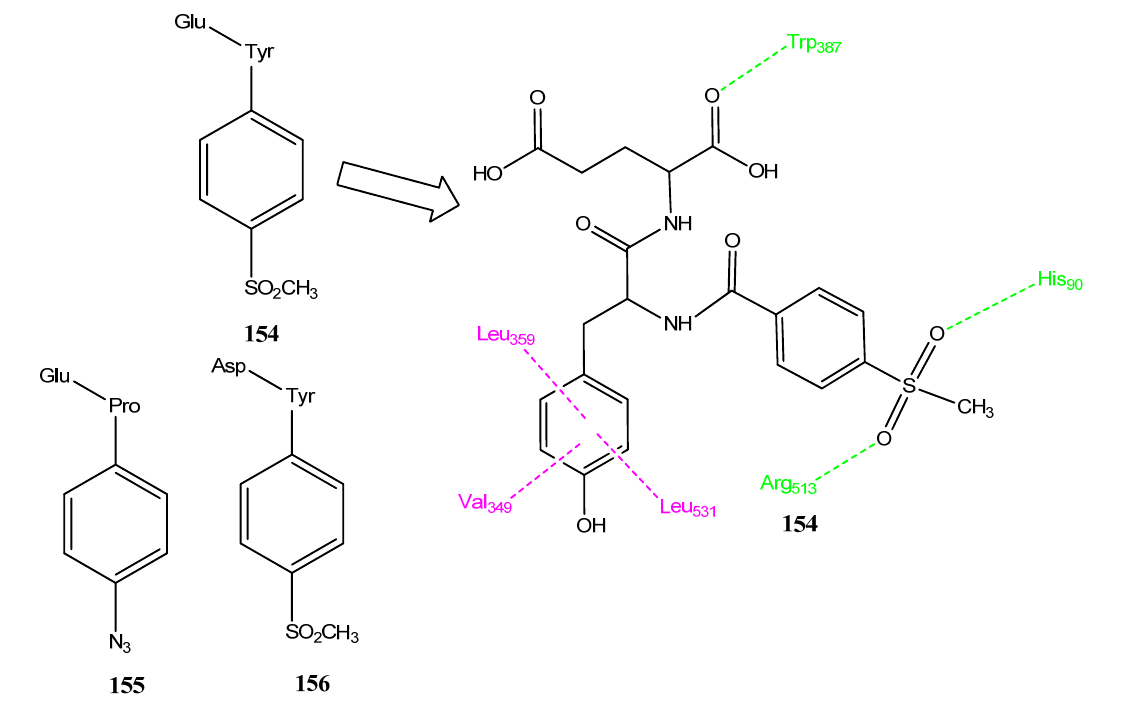
Figure 30. Peptides as COX-2 inhibitors.